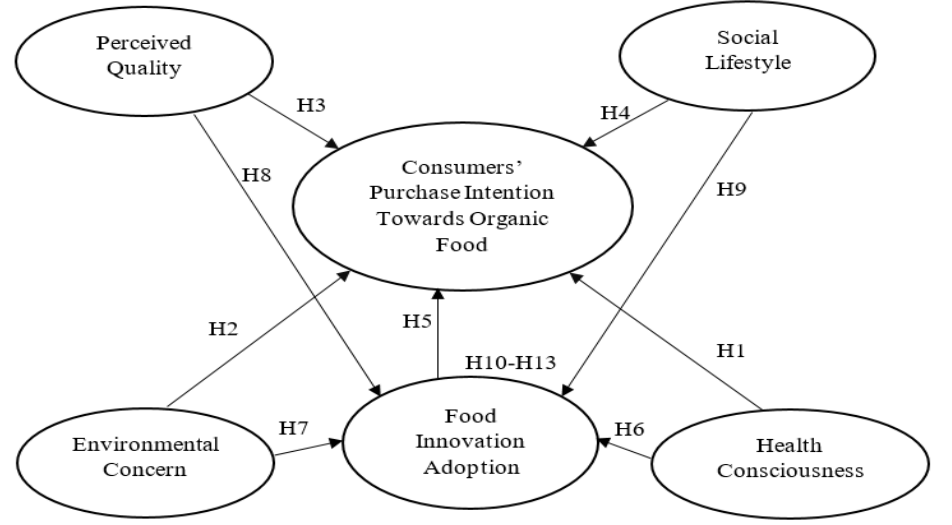
Figure 1. Research theoretical framework.